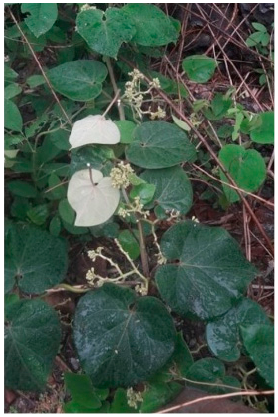
Figure 1. Marsdenia tenacissima .